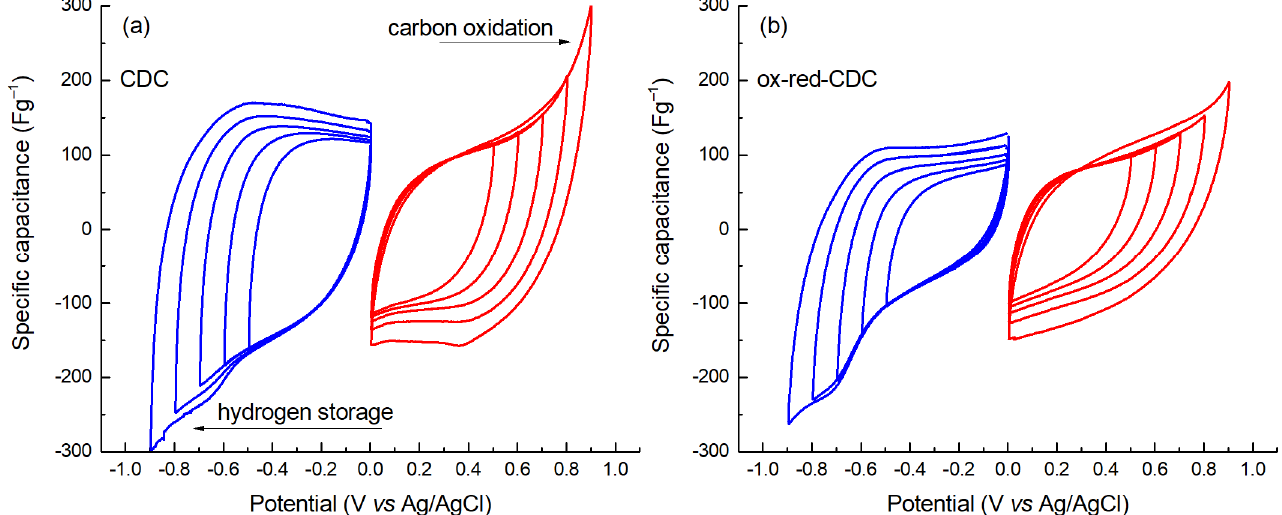
Figure 2. CV curves ( v = 2 mV s − 1 ) for positively and negatively charged electrodes of CDC ( a ) and ox-red-CDC ( b ).